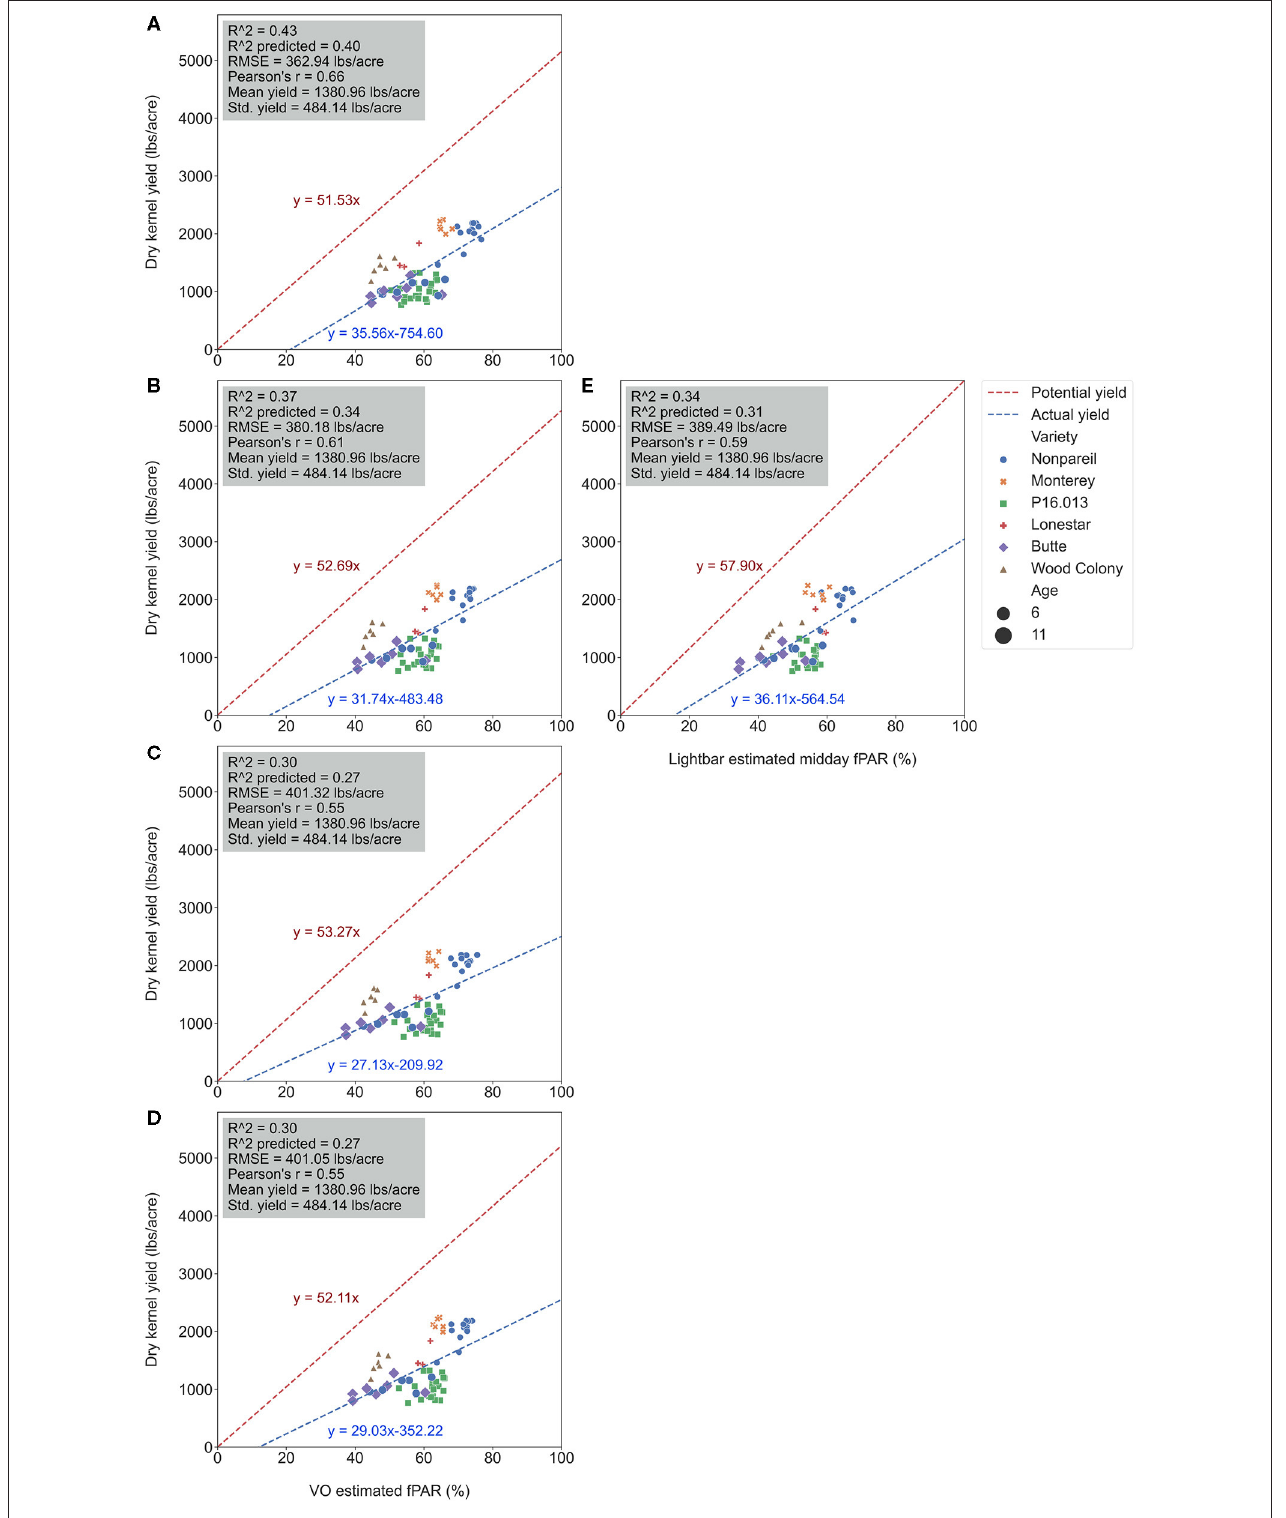
FIGURE 7 | Comparison of accuracies of actual almond yield explained by Virtual Orchard (VO) estimated canopy Fractional PAR (fPAR) over the season: May 28 (A) , June 26 (B) , July 26 (C) , August 7 (D) , and the mobile lightbar platform (June 26) (E) at the per-row level in 2019. The potential almond yield (57.9 lb acre − 1 ) was based on the results reported by Jin et al. (2020) using a lightbar.